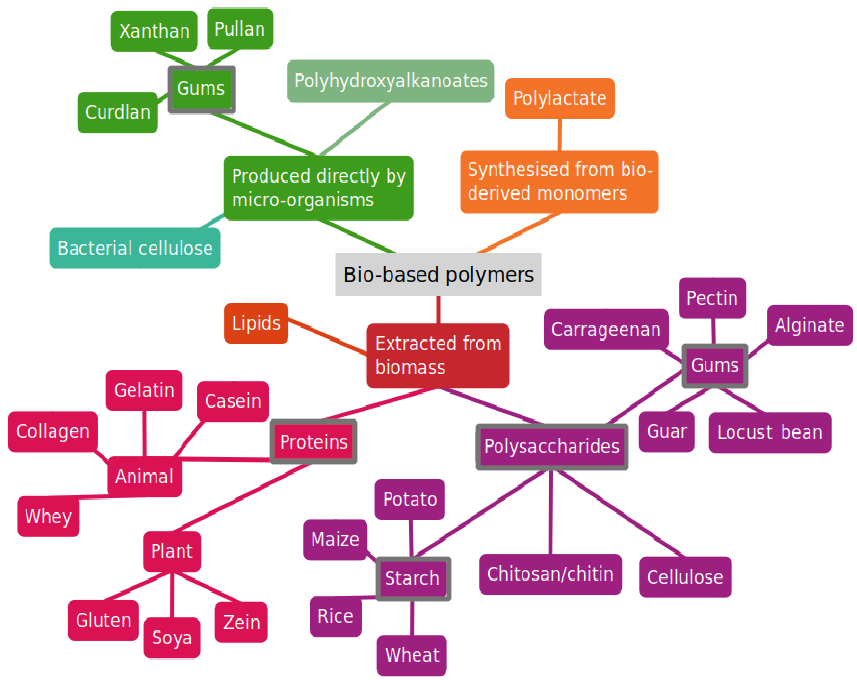
Figure 1. Bio-based polymers used in food packaging applications.